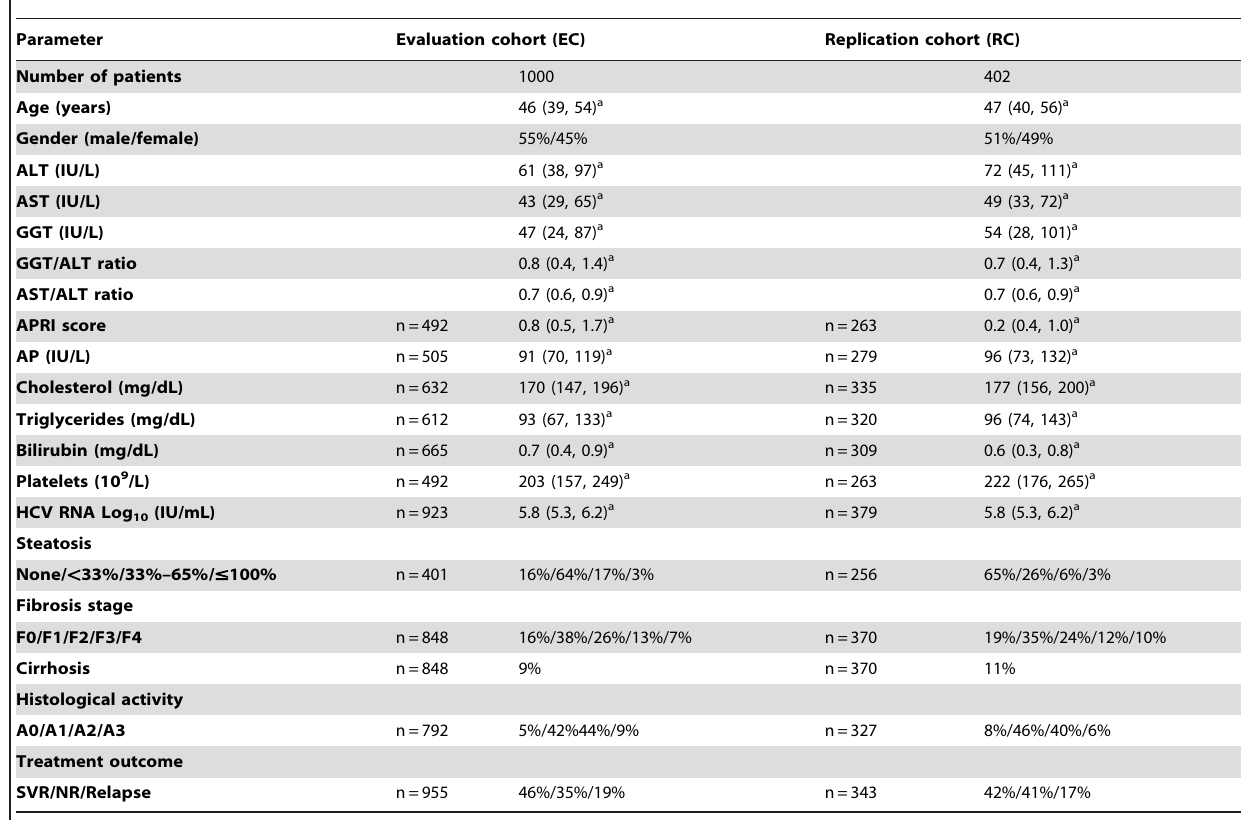
Table 1. Patients’ characteristics of the evaluation and replication cohort.